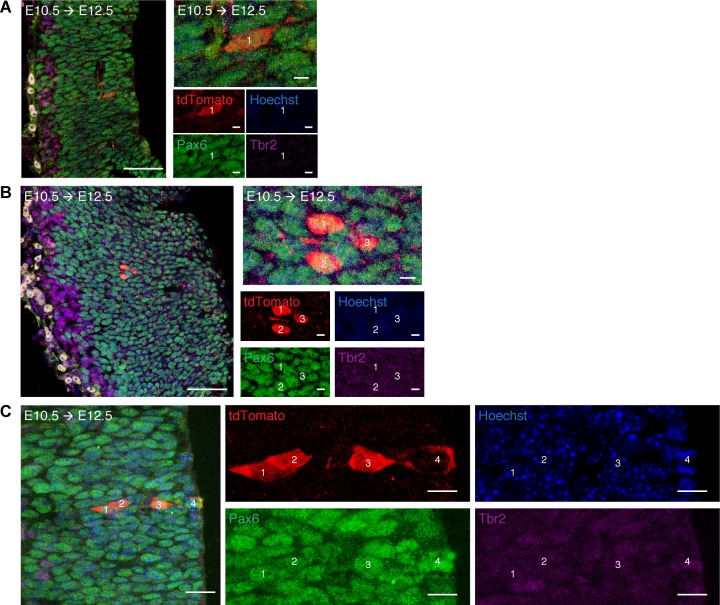
Progenitor composition of clones examined at E12.5 following tamoxifen administration at E10.5, additional examples expanding on Figure 1G–J.Immunohistochemical staining at E12.5 for Pax6 (green), Tbr2 (magenta), and tdTomato (red) was used to characterize the progenitor composition of clones following tamoxifen administration at E10.5. Examples of clones with 1 (A), 3 (B) or 4 (C) radial glia arranged in 1 (A), 2 (B) and 1 (C) proliferative unit(s) are shown. All panels are oriented with the ventricular zone on the right side and the pial surface on the left. For panels A and B, scale bars are 50 µm on the left and 5 µm on the right, respectively. For panel C, scale bars are 10 µm on the left and 5 µm on the right, respectively. An example with two radial glia arranged in one proliferative unit (the most common pattern) is shown in Figure 1G–H.